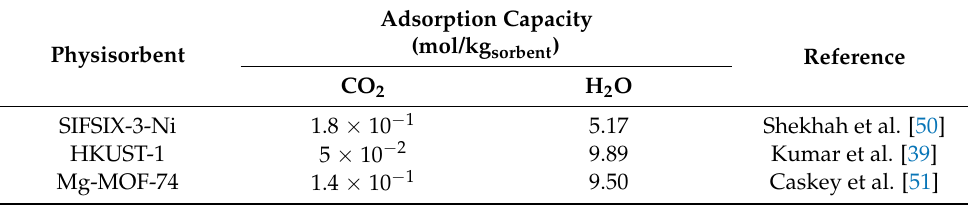
Table 2. Adsorption capacity of some physisorbents from ambient air at 49% of relative humidity.